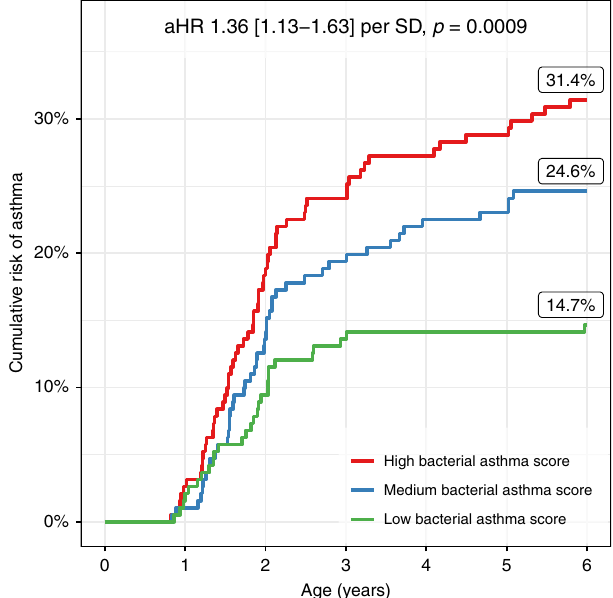
Fig. 1 Differential abundance and asthma. Hazard ratios and corresponding p values from Cox proportional hazards regression models using log-transformed relative abundances for each genus as a predictor for asthma by age 6 years. Dashed line indicates 5% false discovery rate (FDR) cutoff. Colored by taxonomic phylum. n = 573